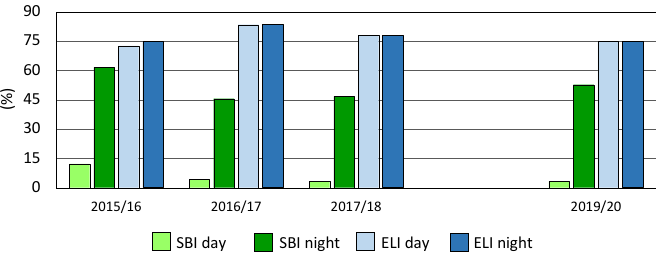
Figure 2. Frequency (%) of the surface-based (SBI) and elevated (ELI) inversion layers.